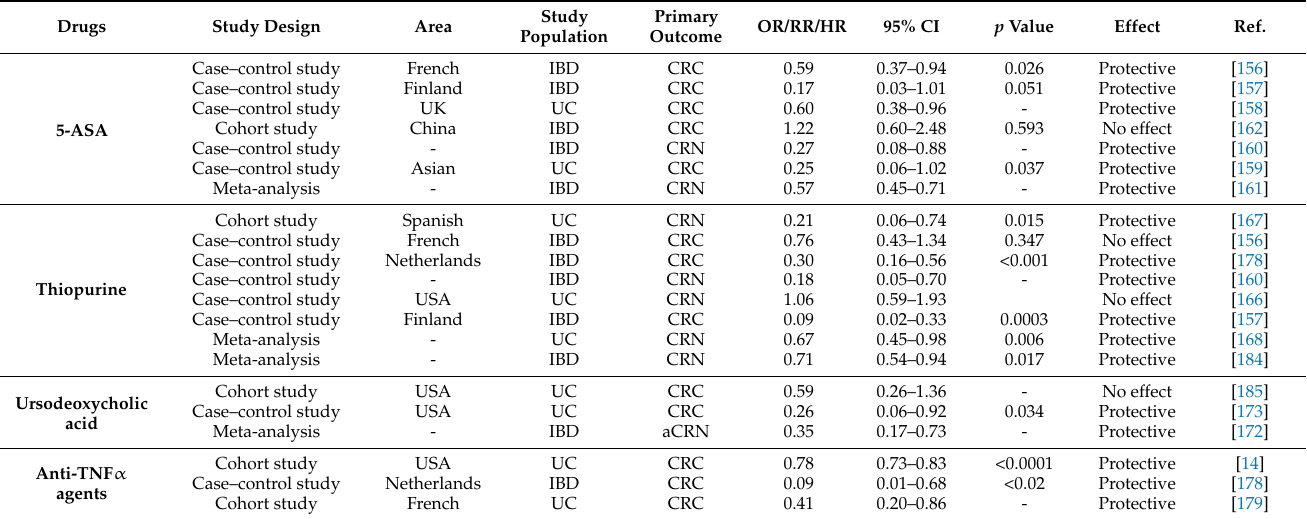
Table 2. Studies assessing potential main prevention agents in IBD